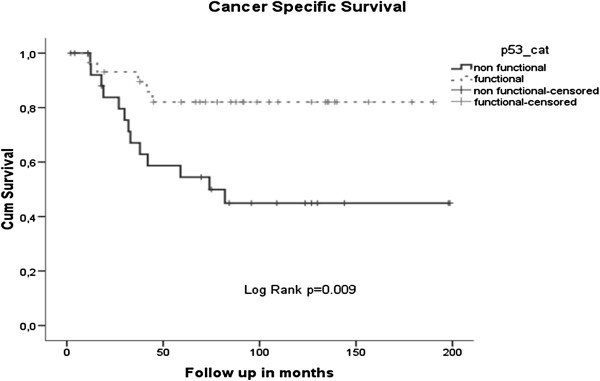
Kaplan Meier plots for CSS according to p53 functionality.